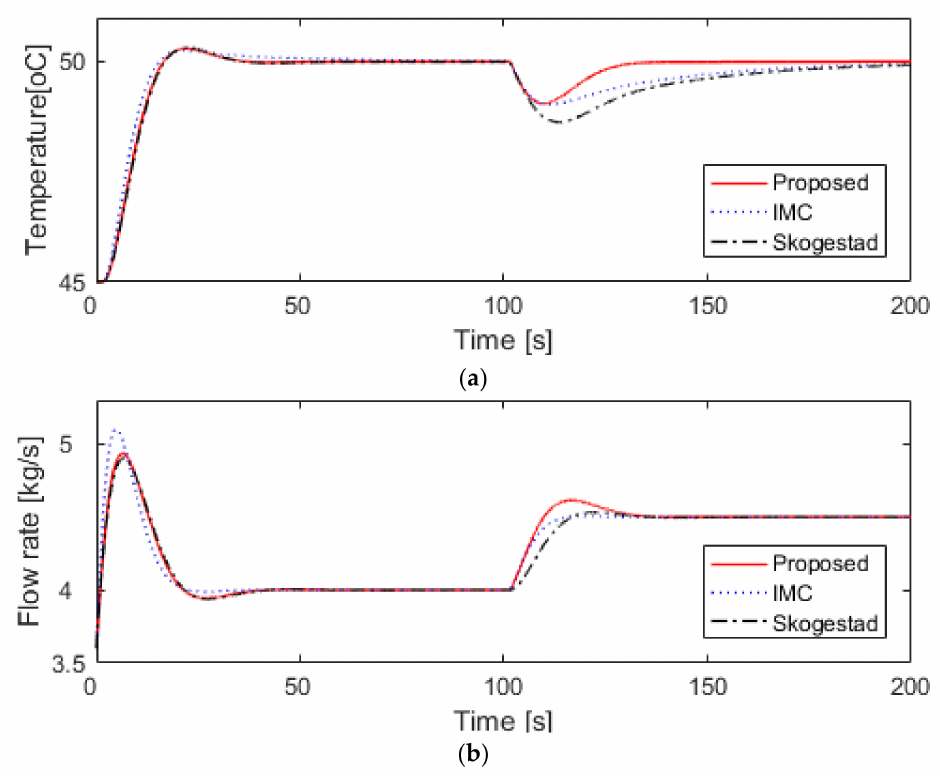
Figure 6. Step responses and steam flow rate for nominal heat exchanger. ( a ) Step responses; ( b ) steam flow rate. Table 3. Comparison of performances for nominal heat